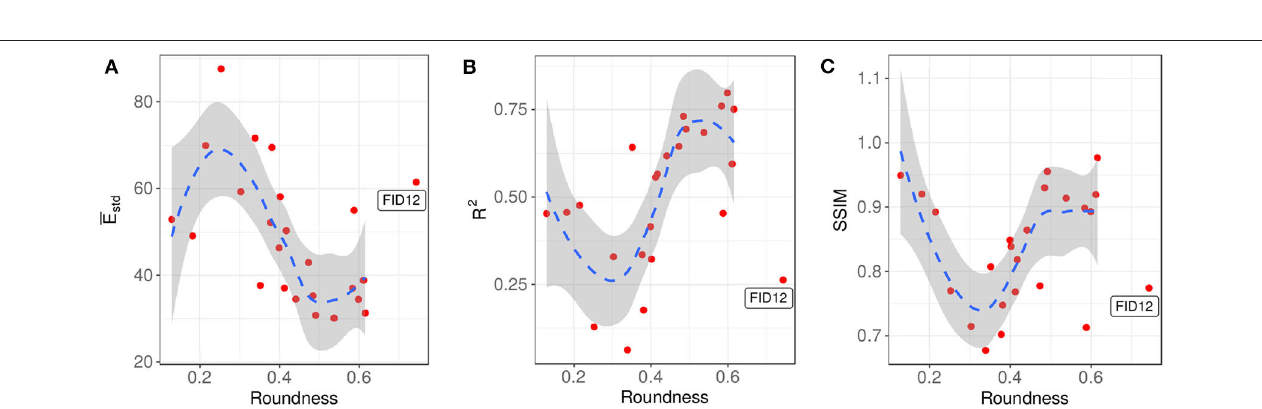
FIGURE 12 | Three selected normalized assessment indices vs. the landslide scarp roundness. The roundness vs. (A) ¯ E std , (B) R 2 , and (C) the SSIM. The dashed lines are obtained by LOESS regression, with a default span parameter of 0.75 (Cleveland et al., 1992). The gray shaded areas indicate 95% confidence intervals. FID12 is an outlier and is excluded from the regression